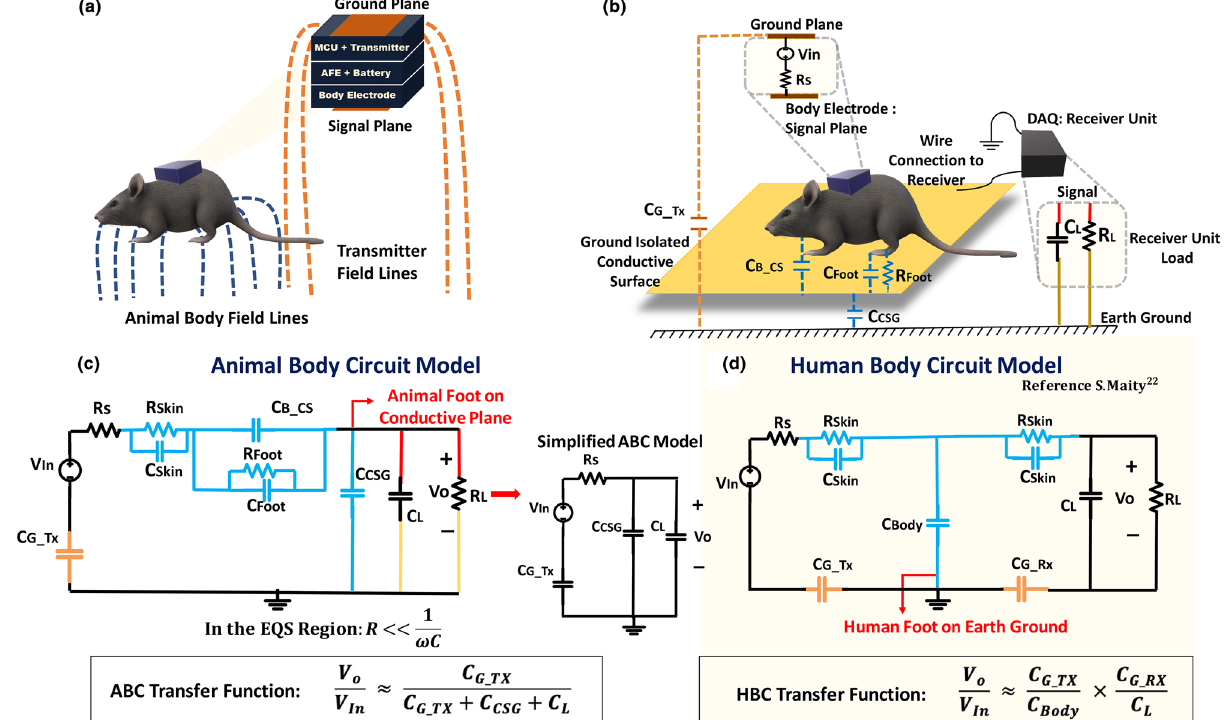
Figure 2. Animal Body Communication model: ( a ) Represents the field lines corresponding to the rat body and the transmitter ground plane. ( b ) The rat body couples to the conductive plane and the associated capacitances are depicted. The conductive plane is ground isolated and forms the capacitance C CSG . The node consists of the ground plane which couples with the earth’s ground to form the capacitive return path. ( c ) The circuit model associated with the experimental setup is shown in the figure. The simplified model of the animal body communication circuit shows that the output voltage is proportional to the conductive plane to ground capacitance C CSG , return path capacitance C G _ TX , and load capacitance C L . ( d ) Simplified Human Body Communication circuit model and transfer function as depicted by Maity et al. 22 . The rat models in (a) and (b) were created using the software Paint 3D by Microsoft Corporation (Version